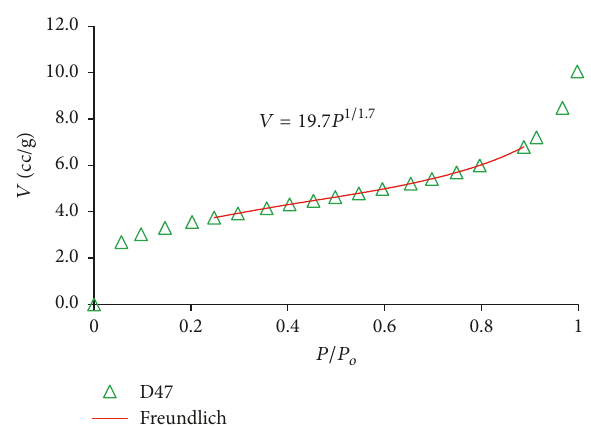
Figure 4: Application of Freundlich isotherm to liquefied nitrogen adsorption isotherm for shale for medium-high relative pressure